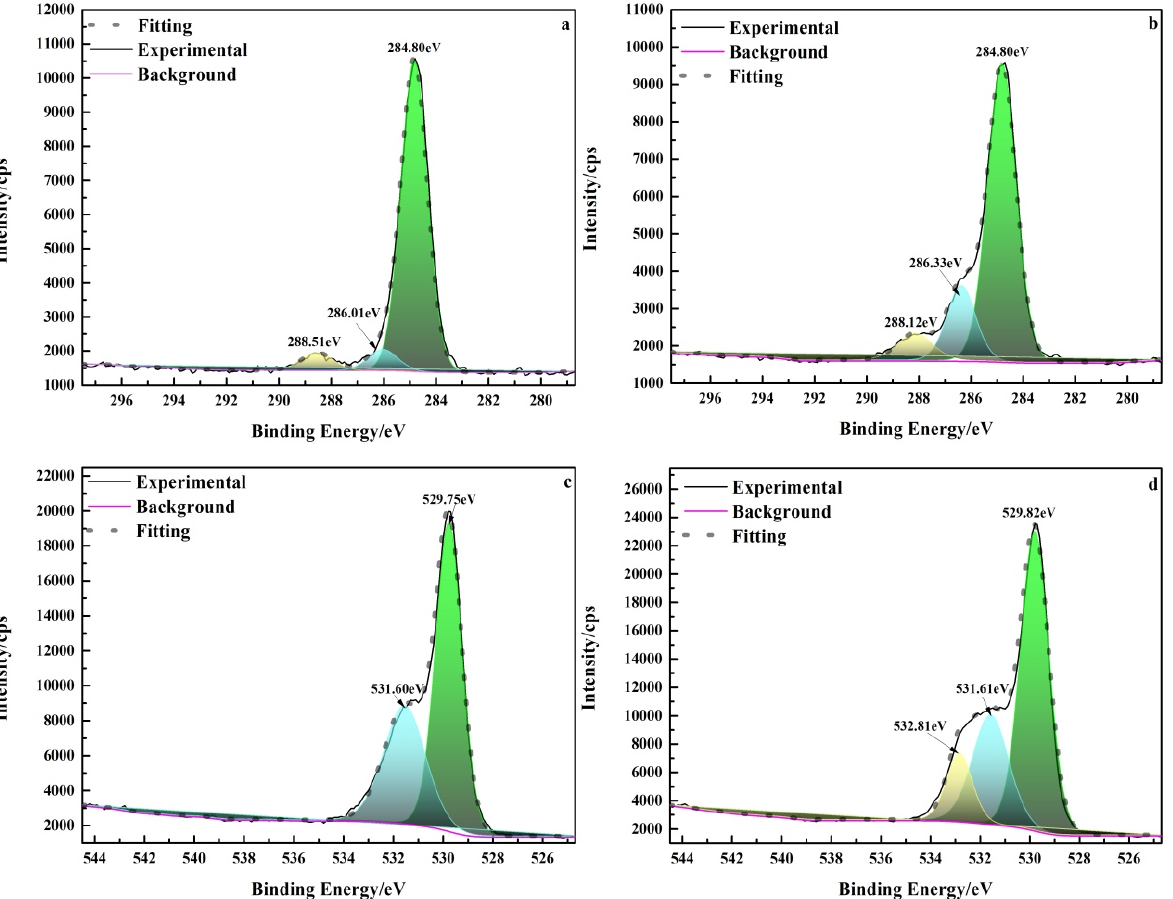
Figure 10. High-resolution XPS spectra of hematite before and after pullulan treatment. ( a ) C1s of hematite; ( b ) C1s of hematite + pullulan; ( c ) O1s of quartz; ( d ) O1s of quartz + pullulan).